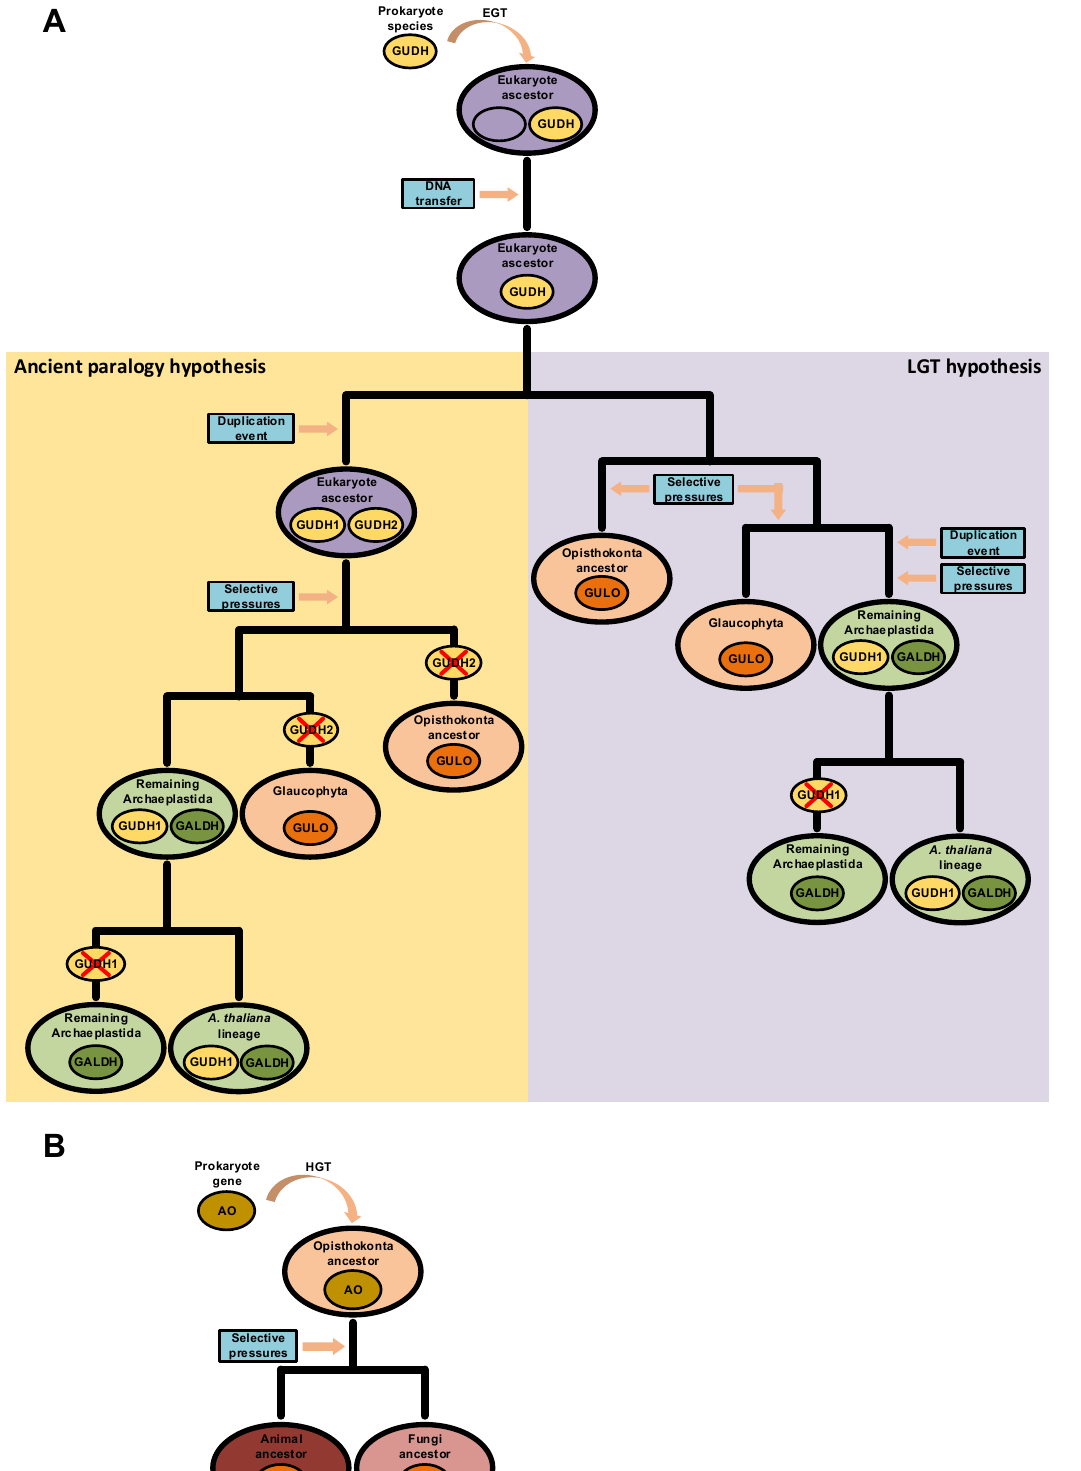
Figure 4. Putative scenarios of eukaryote AO evolution derived from prokaryote LGT events. In panel ( A ), a prokaryote GUDH was initially integrated in the genome of the ancestral eukaryote after an EGT event. Two hypotheses for the divergence of GUDH in eukaryotes are presented. In the left (yellow background), the GUDH present in the ancestral eukaryote was duplicated, originating GUDH1 and GUDH2 . Distinct selective pressures led to the loss of the GALDH ancestral gene ( GUDH2 ) in glaucophytes and opisthokonts, and thus GULO is the result of GUDH1 evolution. In